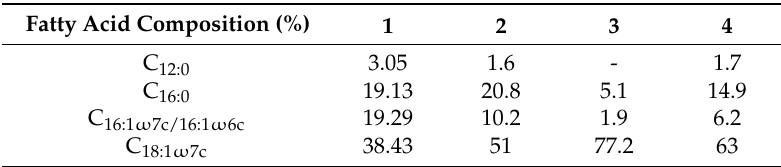
Table 2. Cellular fatty acid profiles (%) of Smobiisys501 and closely related species of the genus Rhodopseudomonas